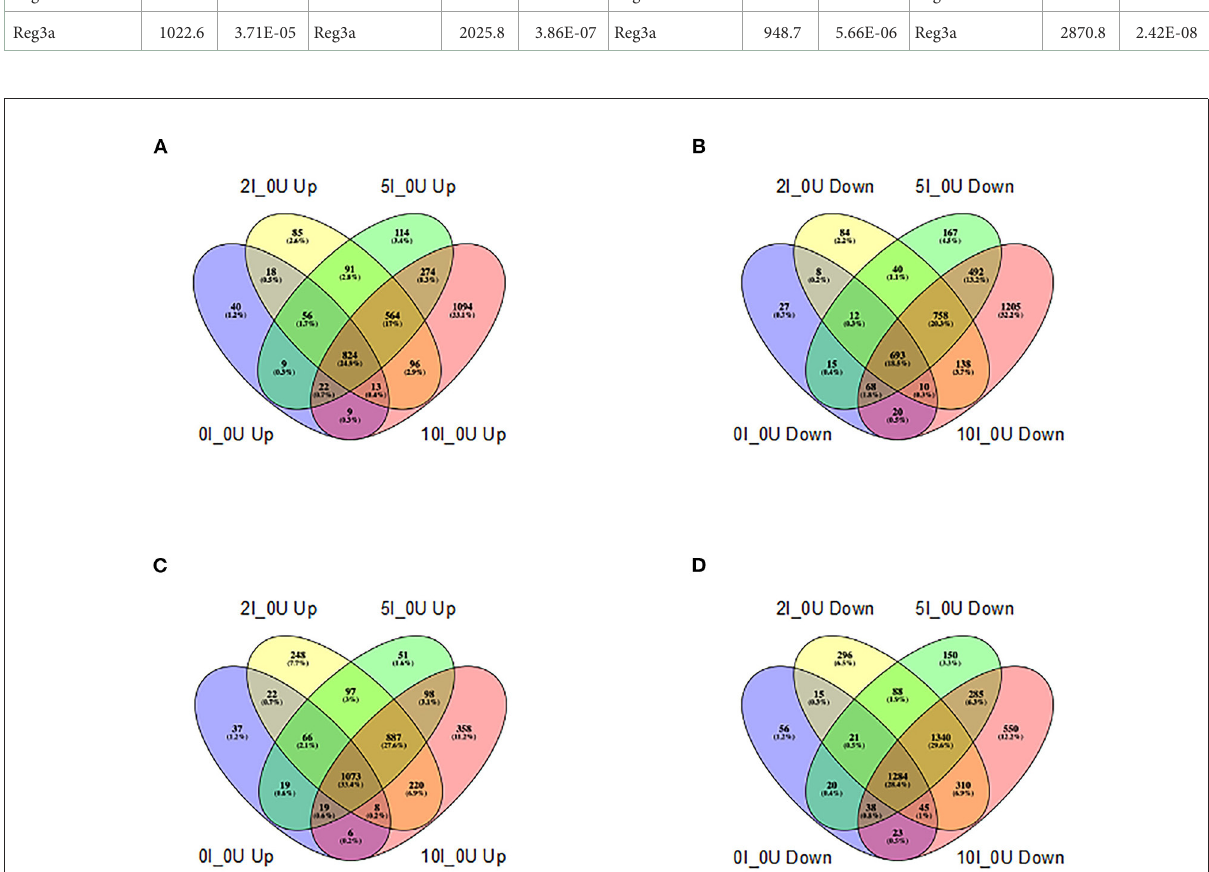
FIGURE7 Venn analysis of differentially expressed genes in cecum and distal colon of Cr -infected mice. Differentially expressed genes (up-or downregulated) > 1.5 fold at a FDR adjusted p < 0.05) in each tissue in animals fed 10% RPS, were analyzed by Venn analysis using the online tool Venny2.1 (https://bioinfogp.cnb.csic.es/tools/venny/). Genes that were upregulated (A) or downregulated (B) in cecum or upregulated (C) or downregulated (D) in DC. n =